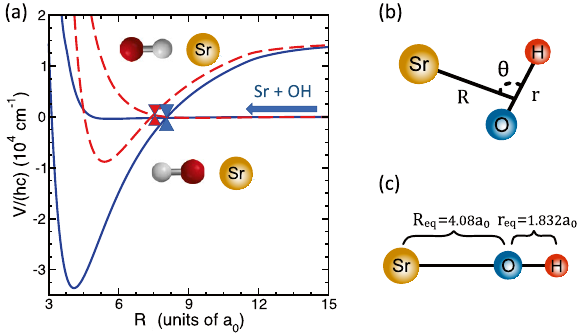
Figure 1. Relevant two-dimensional potential energy surfaces of non-reactive Sr + OH( 2 (cid:31) ) as functions of Jacobi coordinates R . ( a ) Potential energies of the 1 2 A ′ ( X 2 � + ) and 4 2 A ′ ( F 2 �) states as functions of R at 180 0 θ ◦ (blue solid curves) and θ = ◦ (dashed-red curves), respectively. Red and blue cones indicate conical = 7.4 a 0 and 8.1 a 0 , respectively. The arrow marks intersections between X and F curves. They are located at R = the entrance channel. ( b ) A schematic depiction of the Jacobi coordinates. ( c ) Jacobi coordinates of the SrOH molecule in optimized